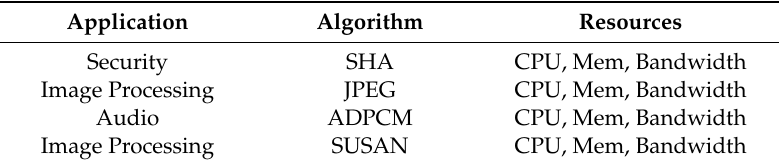
Table 3. Selected applications for the use